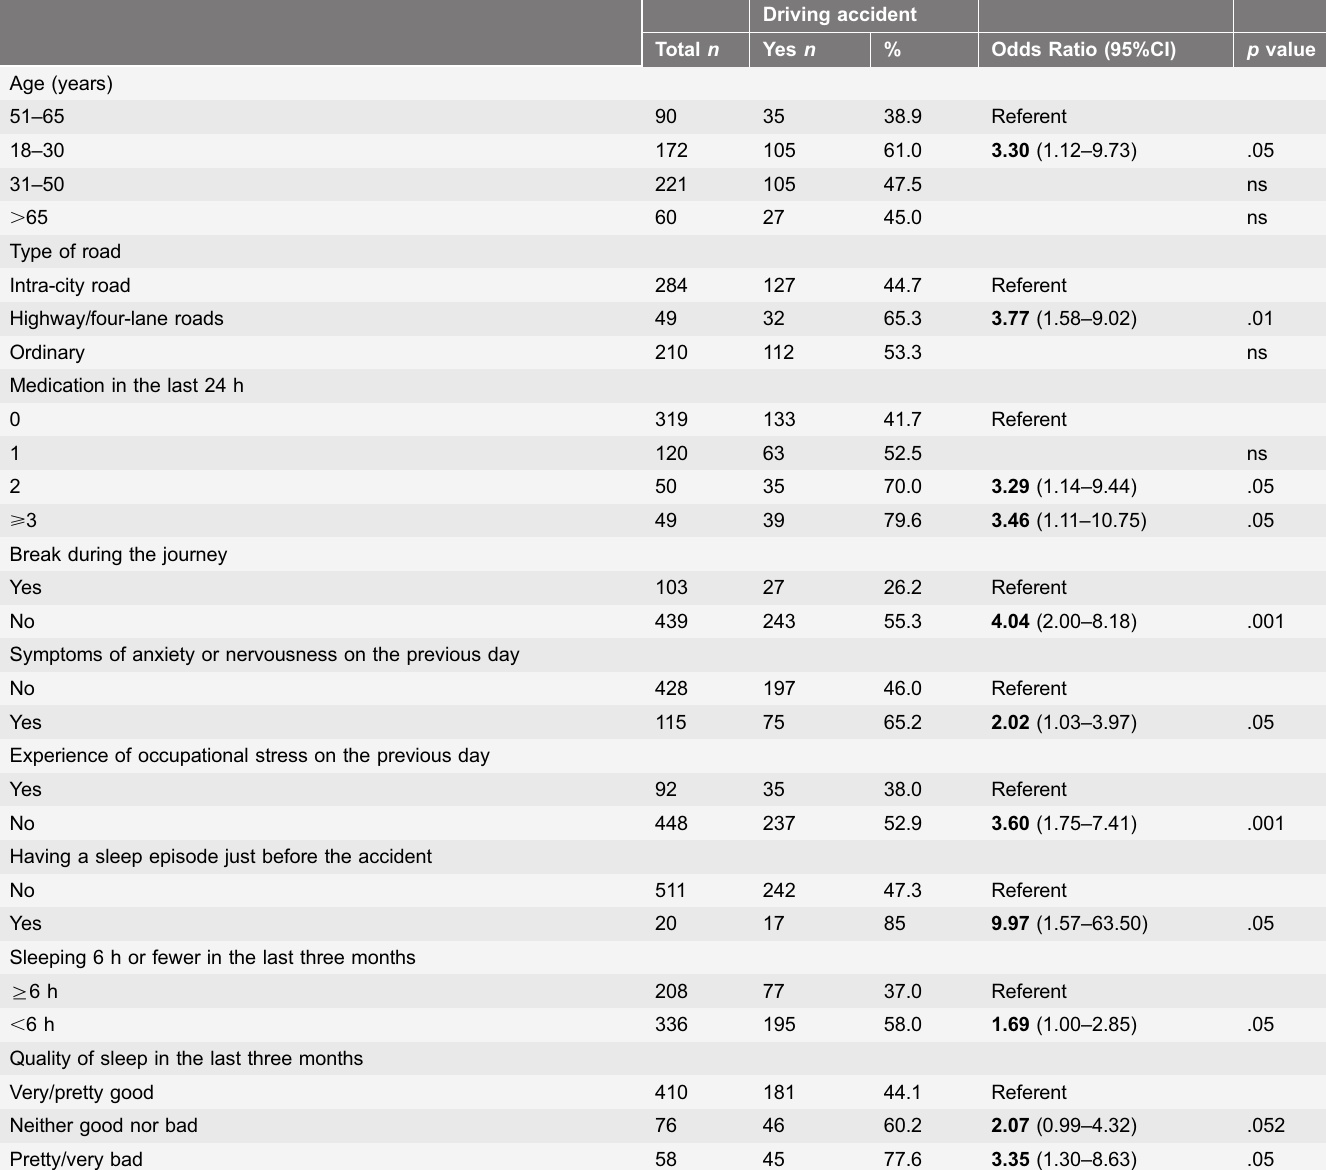
Table 3. Multivariate logistic regression results for prediction of being a case (i.e., having a driving